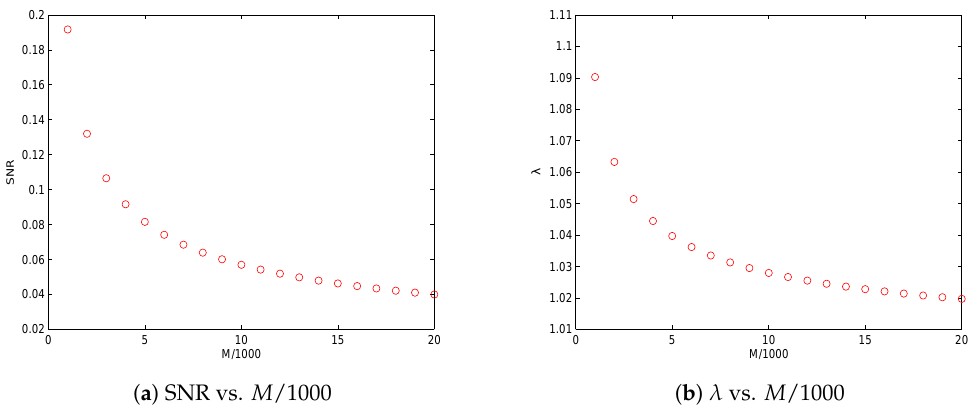
Figure 2. The plot of the solutions ( M , λ ) for (NP 1 ) with SNR = 1 α = 0.05 and σ n = 1. ( a ) The plot of the solutions M of (NP 1 ) vs. 1/SNR. ( b ) The plot of the corresponding λ vs. 1/SNR.